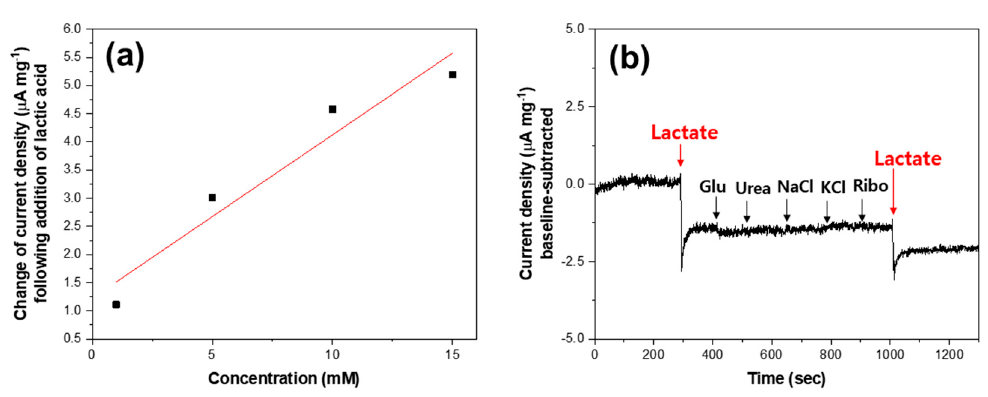
Figure 5. ( a ) Linear relationship between the change of current density and the concentration of lactic acid. ( b ) Amperometric responses to successive additions of 1 mM lactic acid and interfering metabolites of glucose (Glu, 1 mM), urea (1 mM), NaCl (1 mM), KCl (1 mM), and riboflavin (Ribo, 1 mM) at a detection potential of 0.68 V.